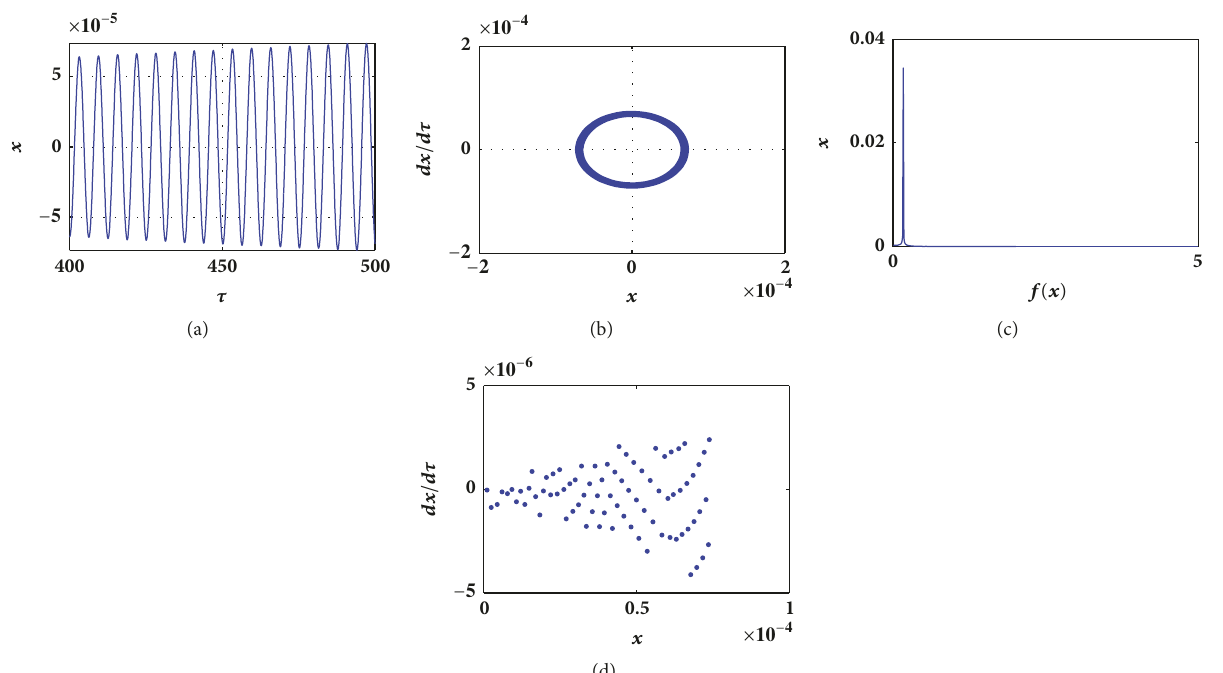
Figure 3: The time history, the phase diagram, spectrum, and the Poincar´e section of the system (6) for 𝜀 = 10 −5 , 𝑄 = 1 .